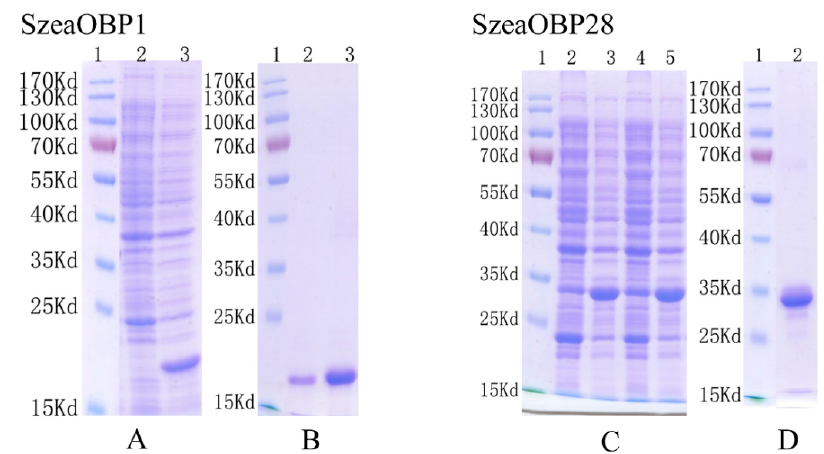
Figure 4. SDS-PAGE and western blot analysis of the expressed products and purified pET-SzeaOBPs. ( A,C ) show the pET-SzeaOBP recombinant protein that was primarily expressed by induction with isopropyl-beta-D-thiogalactopryranoside (IPTG) and detected by SDS-PAGE. ( B,D ) show western blot analyses of the purified SzeaOBPs. Lane 1 in all the images shows the protein molecular weight marker. ( A ) lane 2: SzeaOBP1-transformed Escherichia coli , not induced; lane 3: SzeaOBP1-transformed Escherichia coli , induced. ( B ) lane 2 and 3: recombinant purified SzeaOBP1 protein. ( C ) lanes 2 and 4: